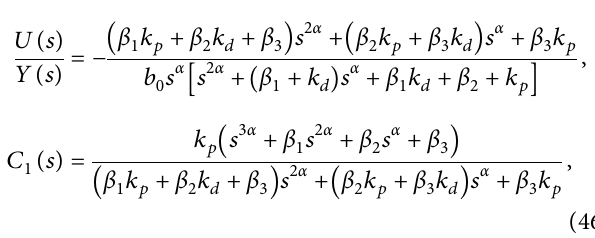
Figure 11: Te frequency-domain characteristic of FOESO input disturbance (observer gain ω o ).